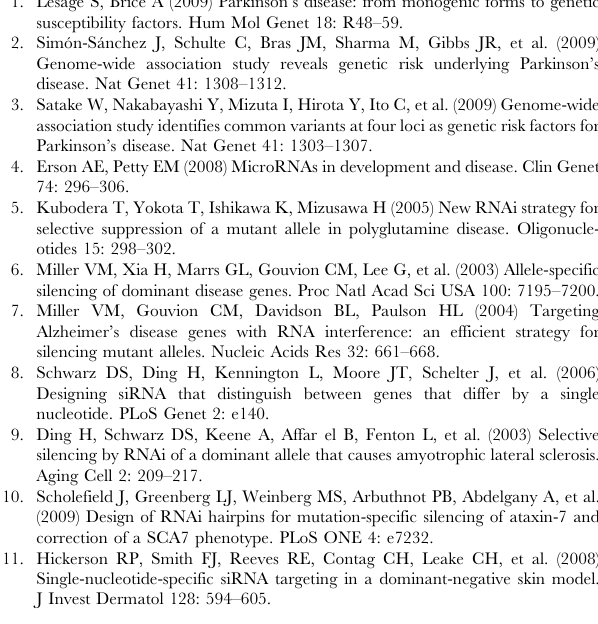
Figure S3 Cell counting and cell viability from cells